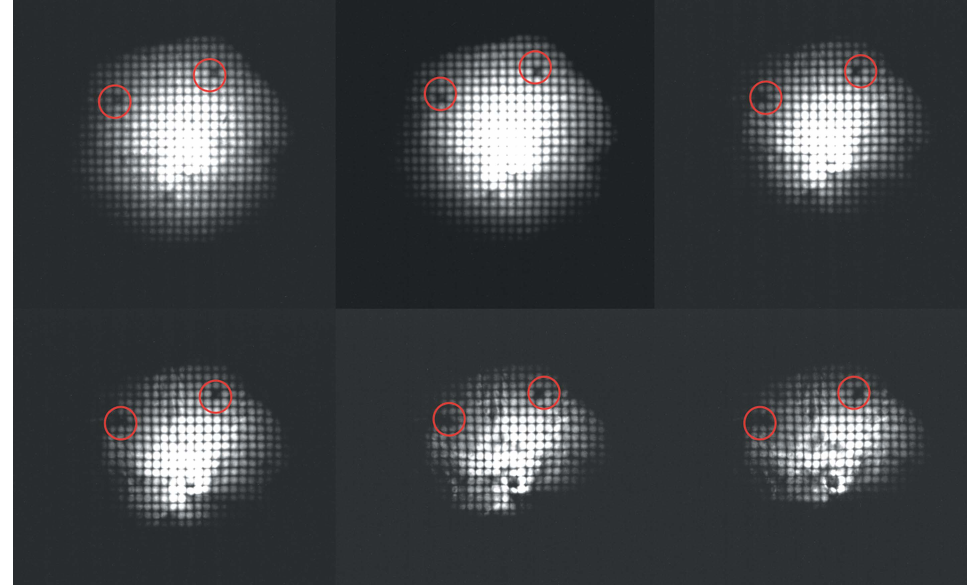
Figure 19 Small fabrication defects of PC-50 identified at beam energies (top-left to bottom-right) of 8 keV, 10 keV,12 keV, 14 keV, 17.5 keV, 20 keV.